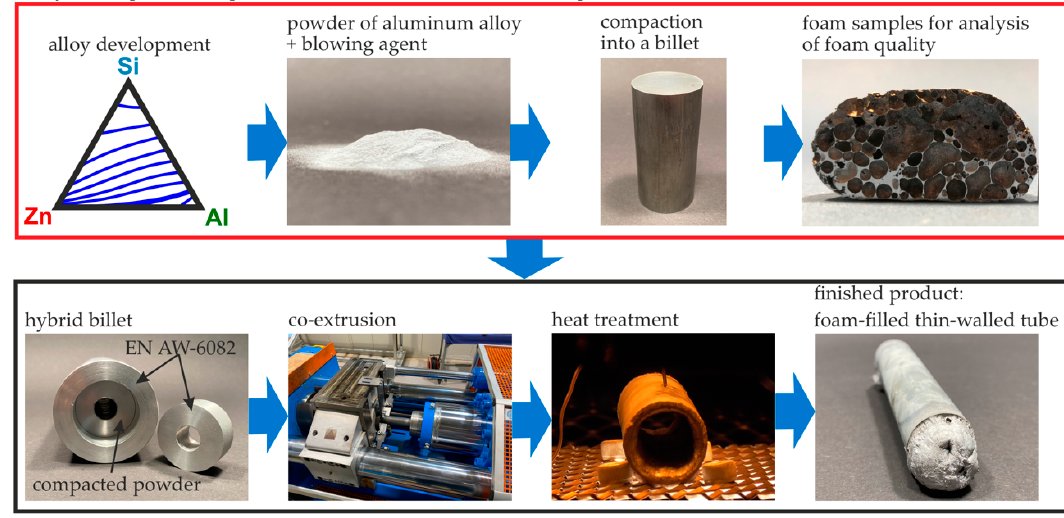
Figure 1. Illustration of the developed process chain for the production of FFTs with a metallurgical bond between foam and the outer wall of the tube; highlighted in the red box are the contents of the present study.